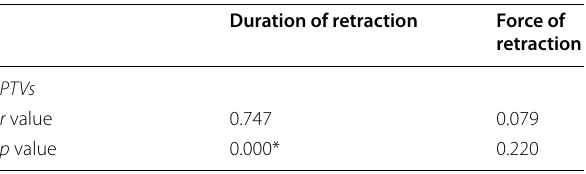
*Statistically significant at p value ˂ 0.05